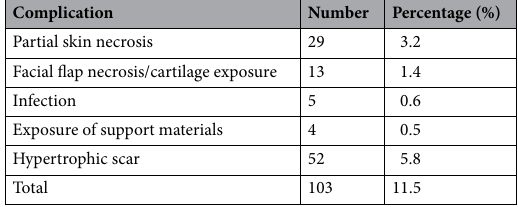
Table 2. Complications after ear elevation in autologous cartilage microtia